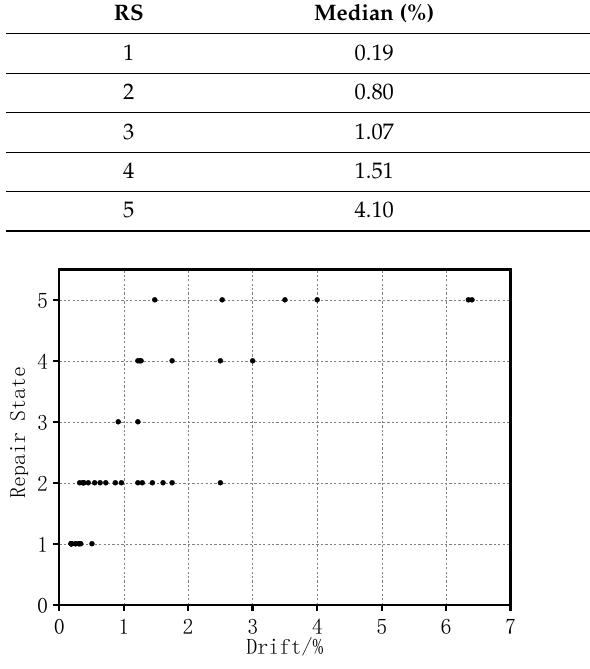
Table 5. The inter-story drift data of 19 tested specimens of each repair state.